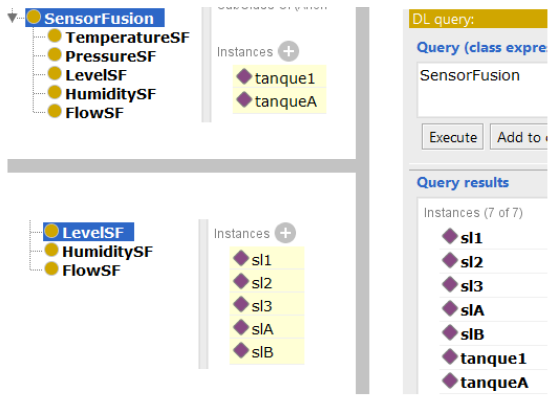
Figure 12. The first query: the upper left side shows the resources with fusion, and on the same side below shows the level sensors that are in fusion; on the right side, the DL Query including all the elements in fusion is